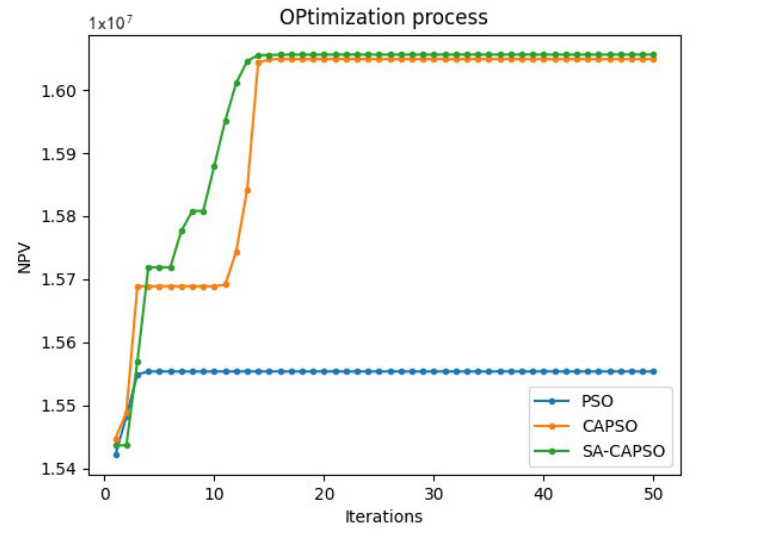
Figure 10. Changes of the NPV under different injection-production